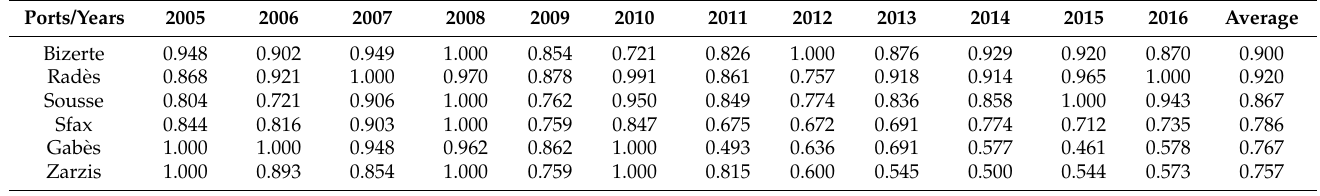
Table 5. Pure technical efficiency scores (DEA-BCC) of Tunisian ports.